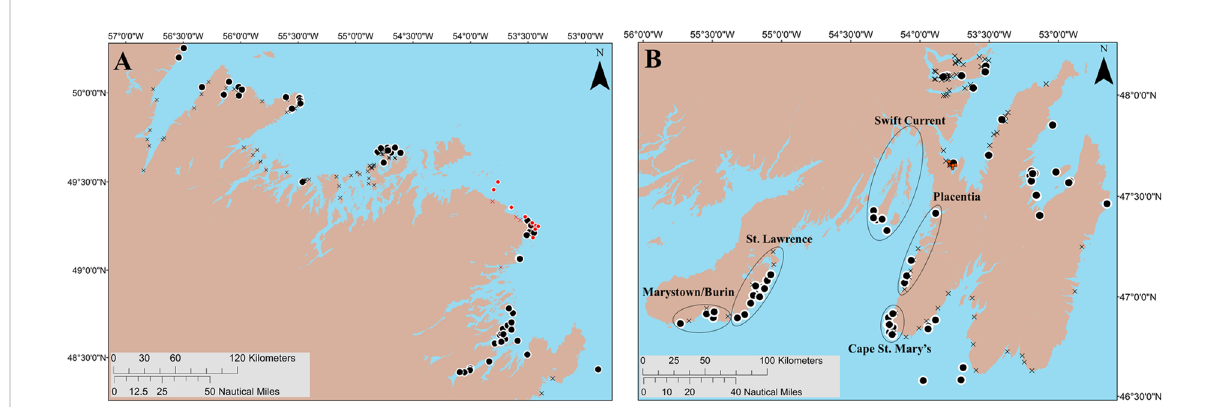
FIGURE 2 The centroids of putative beach (193; black X symbol) and deep-water (101; black circles) spawning areas identi fi ed by interviewees, along with areas previously suggested as important for capelin deep-water spawning by archived fi sher interviews in Placentia Bay (black ellipses; based on Sjare et al., 2003), other known and scienti fi cally monitored deep-water spawning sites (16 red circles; based on Nakashima and Wheeler, 2002 and Penton and Davoren, (2012) and beach spawning sites (10; red X symbol). Panel (A) (left): Capelin fi shing areas 3 – 5; Panel (B) (right): Capelin fi shing areas 6 –